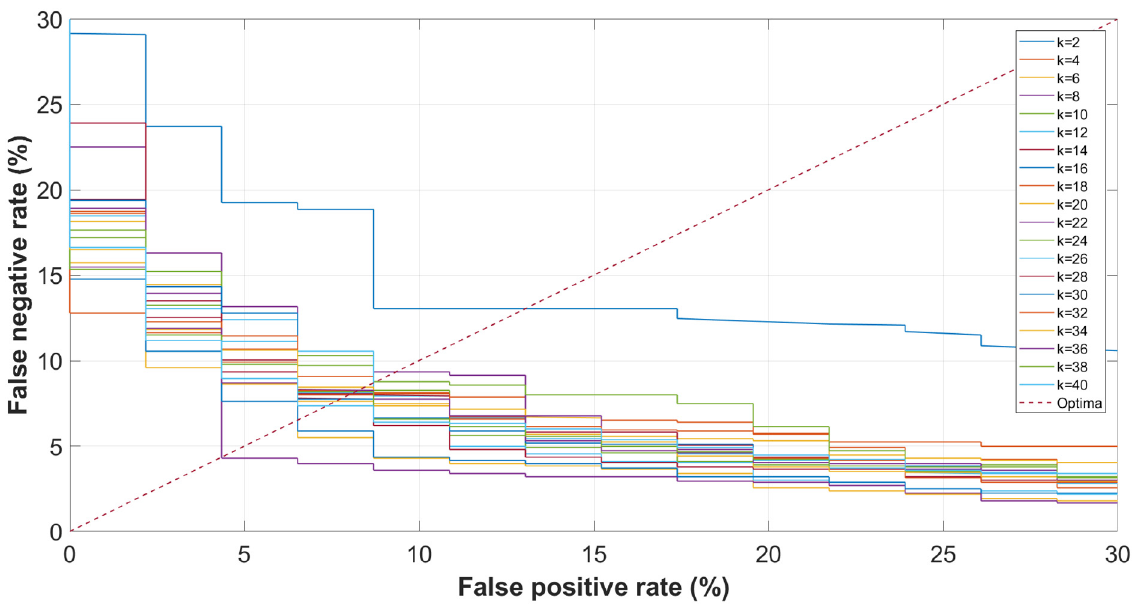
Fig 9. Receiver operating characteristics of the proposed CAPT framework with [ ɑ ].